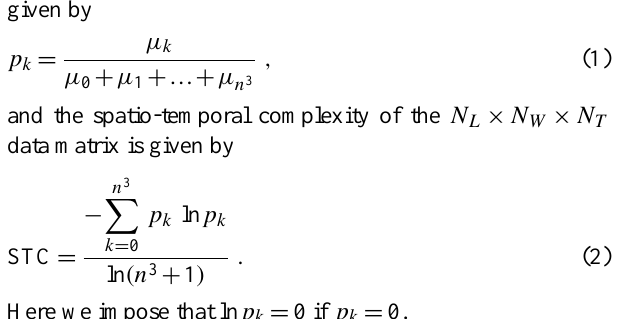
Fig. 1. Schematic of the spatio-temporal complexity analysis: (a) The series of raster-based sea surface temperature (SST) images are stacked into a 3-D space-time matrix. (b) A threshold temperature is applied to generate a binary matrix, in which all cells below the threshold have zero values (shown here as empty cells). An n × n × n moving cube is placed at successive locations in the space-time matrix like a sliding window. At each location, the number of non-zero entries ( m ) in the cube is noted. The relative frequency, p k , that each occupancy level, m , is observed is calculated. (c) Frequency histograms of p k versus m . A highly uneven histogram (left) is indicative of ordered space- time dynamics and gives a low value of spatio-temporal complexity (STC). A bell-shaped histogram (middle) is indicative of a random distribution of non-zero entries in the space-time matrix and gives an intermediate value of STC. A perfectly even histogram (right) arises when the space-time matrix is populated with patches of all different sizes and shapes and gives a maximal value of